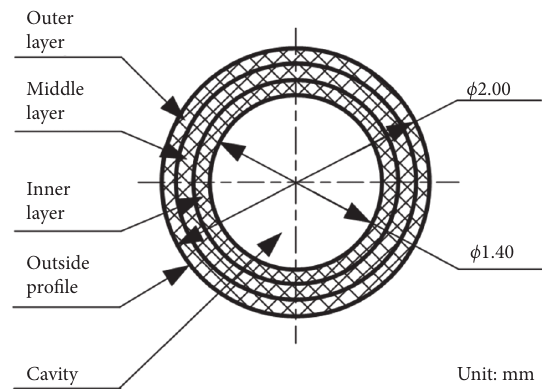
Figure 1: Cross section of three-layered balloon catheter.